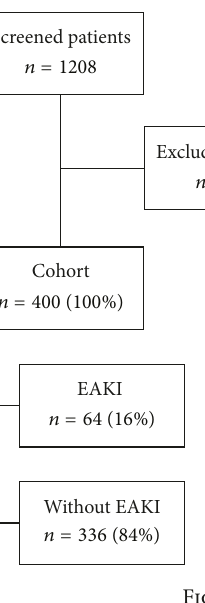
Figure 1: Cohort selection